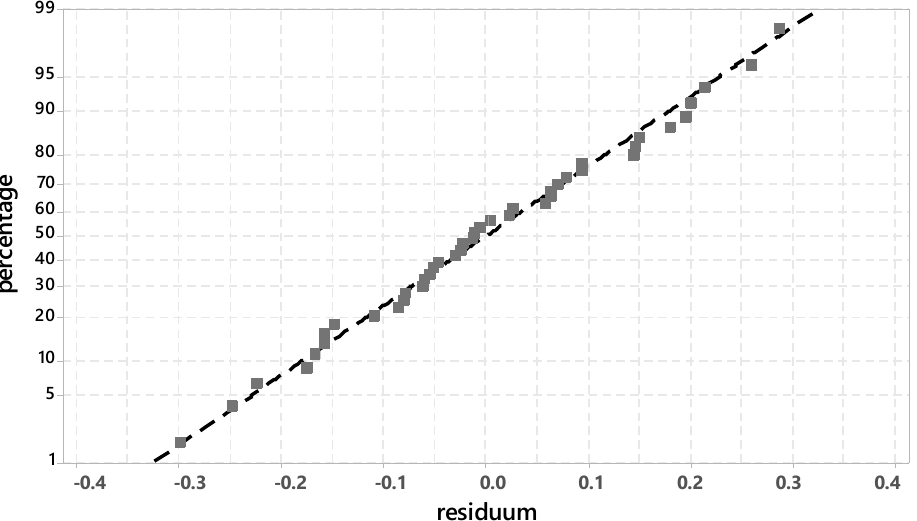
Figure 5. Probability plot for normal distribution for the aluminate phase (XRD ‐ peak 9 ‐ 9.5 °2 ϑ ).